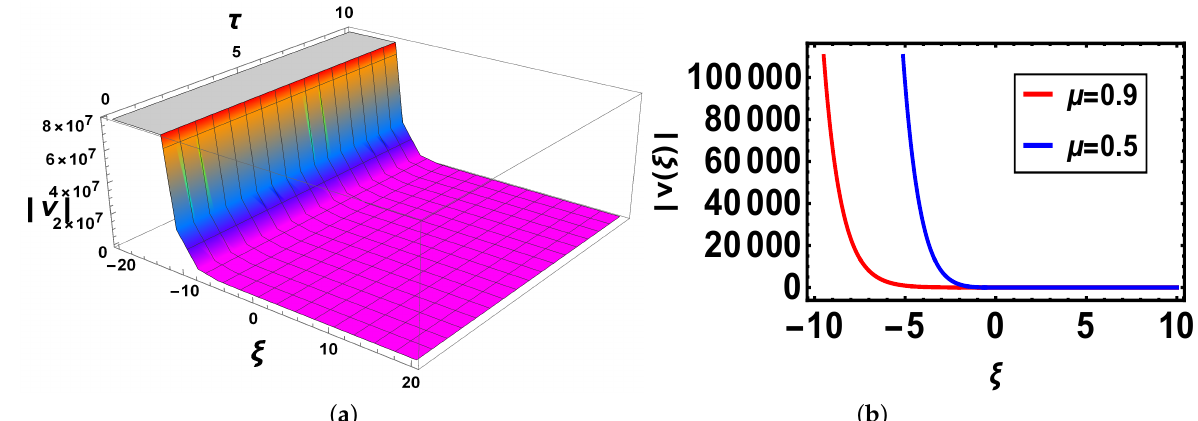
Figure 3. ( a ) 3D and ( b ) 2D plots with same parameter values as above µ = 0.9 and Θ = 1.1 of v 1 ( ξ , τ ) with the beta-derivative.